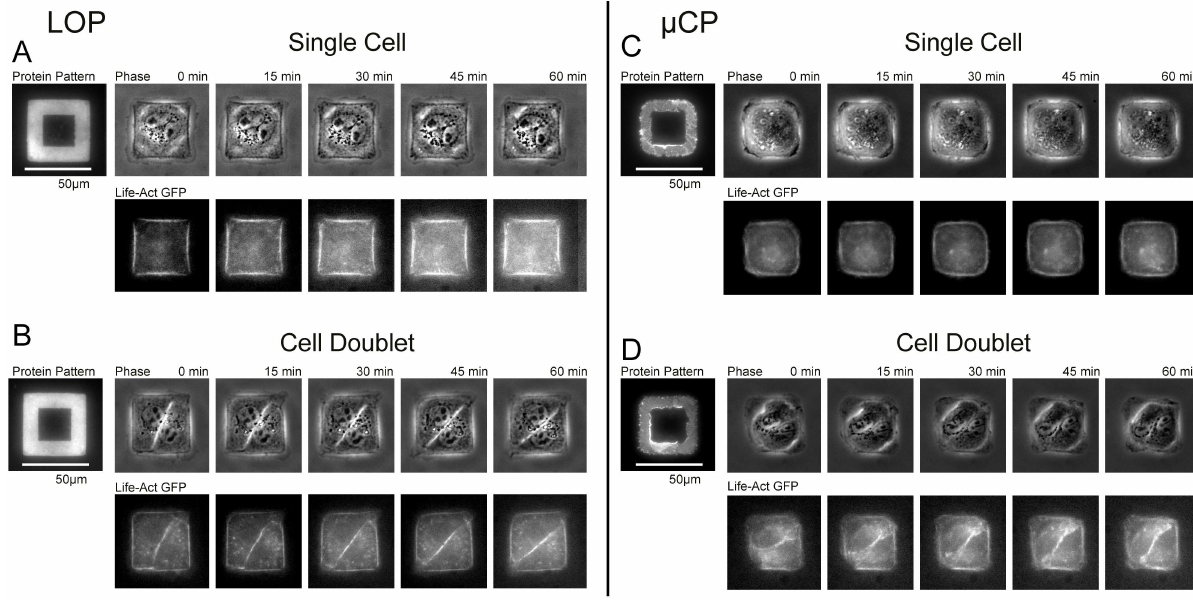
Fig 4. LOP yields sharper cell edges with localized actin bundles compared to μ CP patterned gels. Time-lapse acquisitions of MDCK cells transfected with Lifeact-GFP (actin label) grown on 25 kPa PAAm gels showedsimilar intracellularactin structures on LOP (A, B) and μ CP (C,D) protein patterns. Cell doublets rotated aroundeach other on the patterns for both techniques